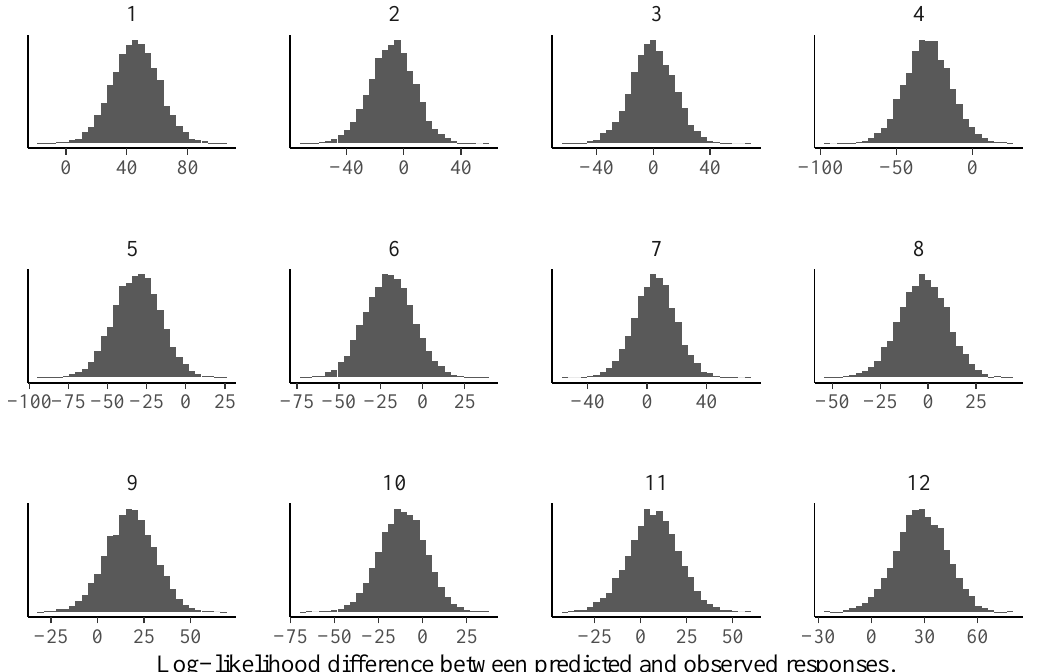
Figure 6. Item-specific posterior distributions of log-likelihood differences between predicted and observed responses for the 1PL model estimated via MCMC-H. If the majority of the posterior distribution is above zero, this indicates model misfit for the given